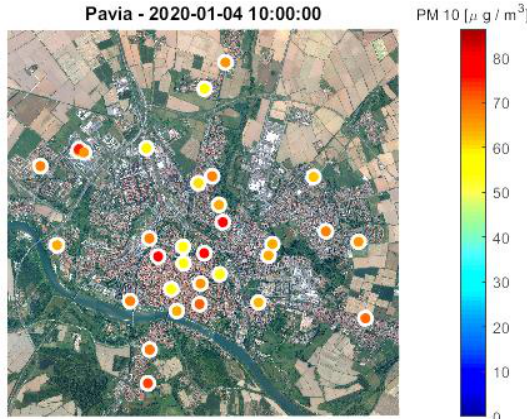
Figure 11. Color-coded measurements for PM 10 and all the monitors; day selected in January 4th, 2020 and time shown is 10:00 AM